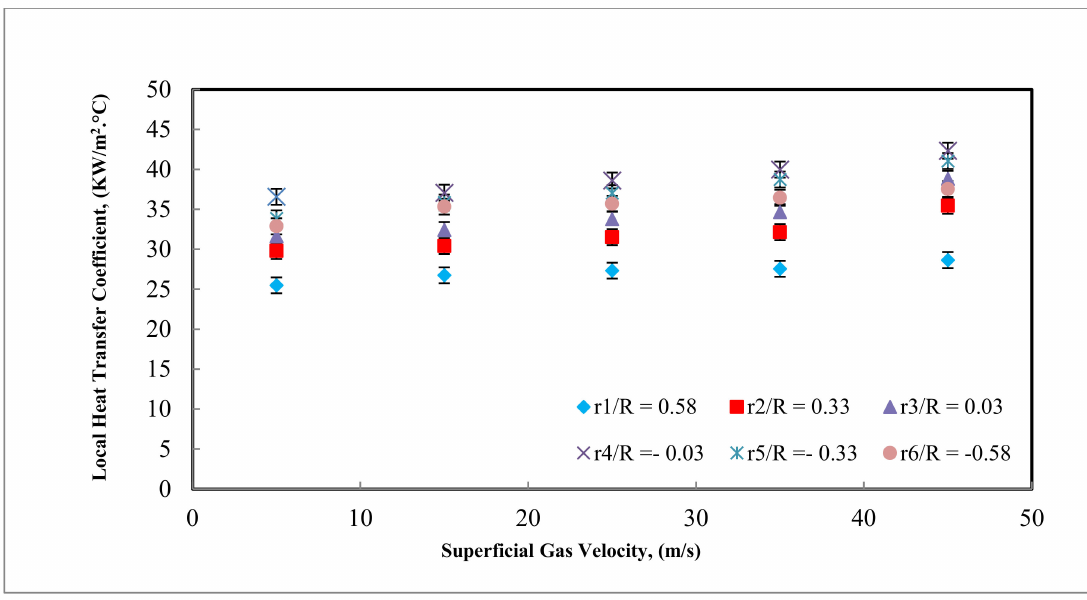
Figure 5. Impact of superficial gas velocity on local heat transfer coefficient at (H/D = 5) for square